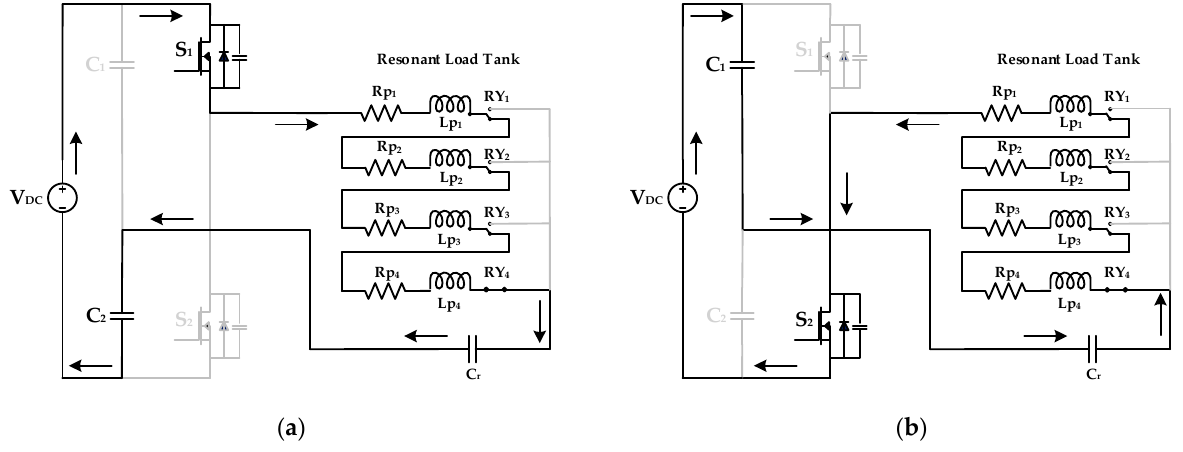
Figure 6. Circuit diagram of Mode 4: ( a ) Switch S 1 in ON state; ( b ) Switch S 2 in ON state.